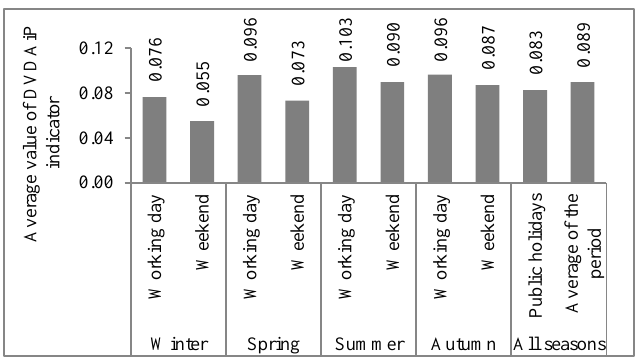
Fig. 5. The daily velocity, which is based on the daily average price, (DVDA iP ) (calculated by the authors).